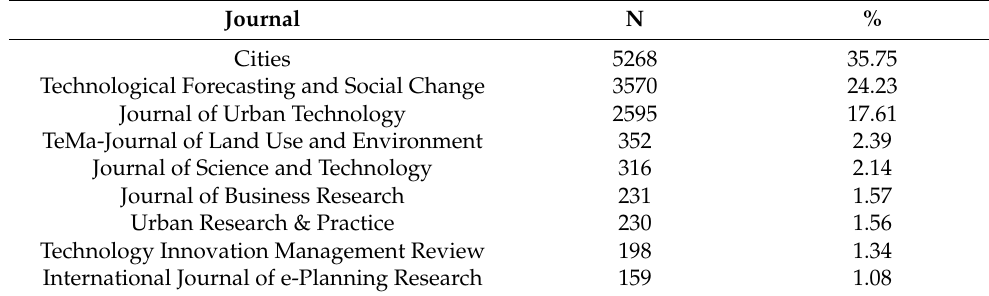
Table 3. Number of citations per